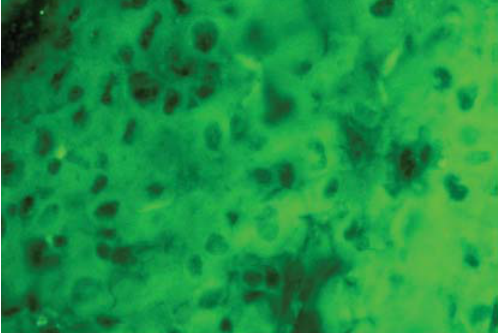
Figure 2 - There is no positive immunofluorescent staining for oxLDL in sham-operated rats